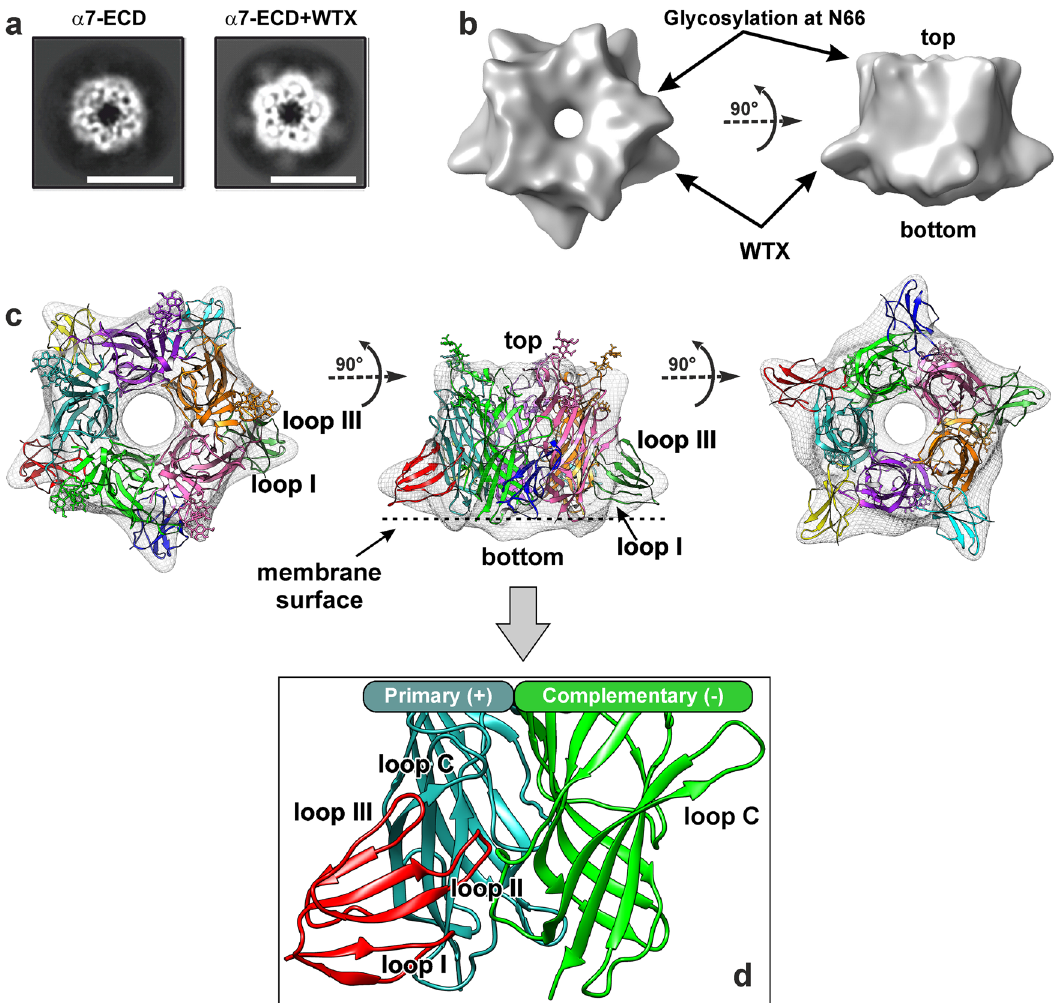
Fig. 2 3D reconstruction of α 7-ECD/WTX complex determined by cryo-EM and computer modeling. a Comparison of the representative top-view 2D class averages for α 7-ECD and α 7-ECD/WTX complex. The fi ne features of pentameric domain complex and density corresponding to fi ve WTX molecules are visible. Scalebar is 10 nm. b 3D density map of α 7-ECD/WTX complex. The features corresponding to the linked glycan fragments and bound WTX molecules are indicated. c Model of α 7-ECD/WTX complex fi tted into experimental 3D density map. The position of the toxin ’ s loops I and III and expected position of membrane interface in the full-length channel are shown. d Enlarged view of WTX interaction with the orthosteric ligand-binding site of α 7-ECD located under the loop C of the primary ( + ) receptor subunit at the interface between the primary ( + ) and complimentary ( − )